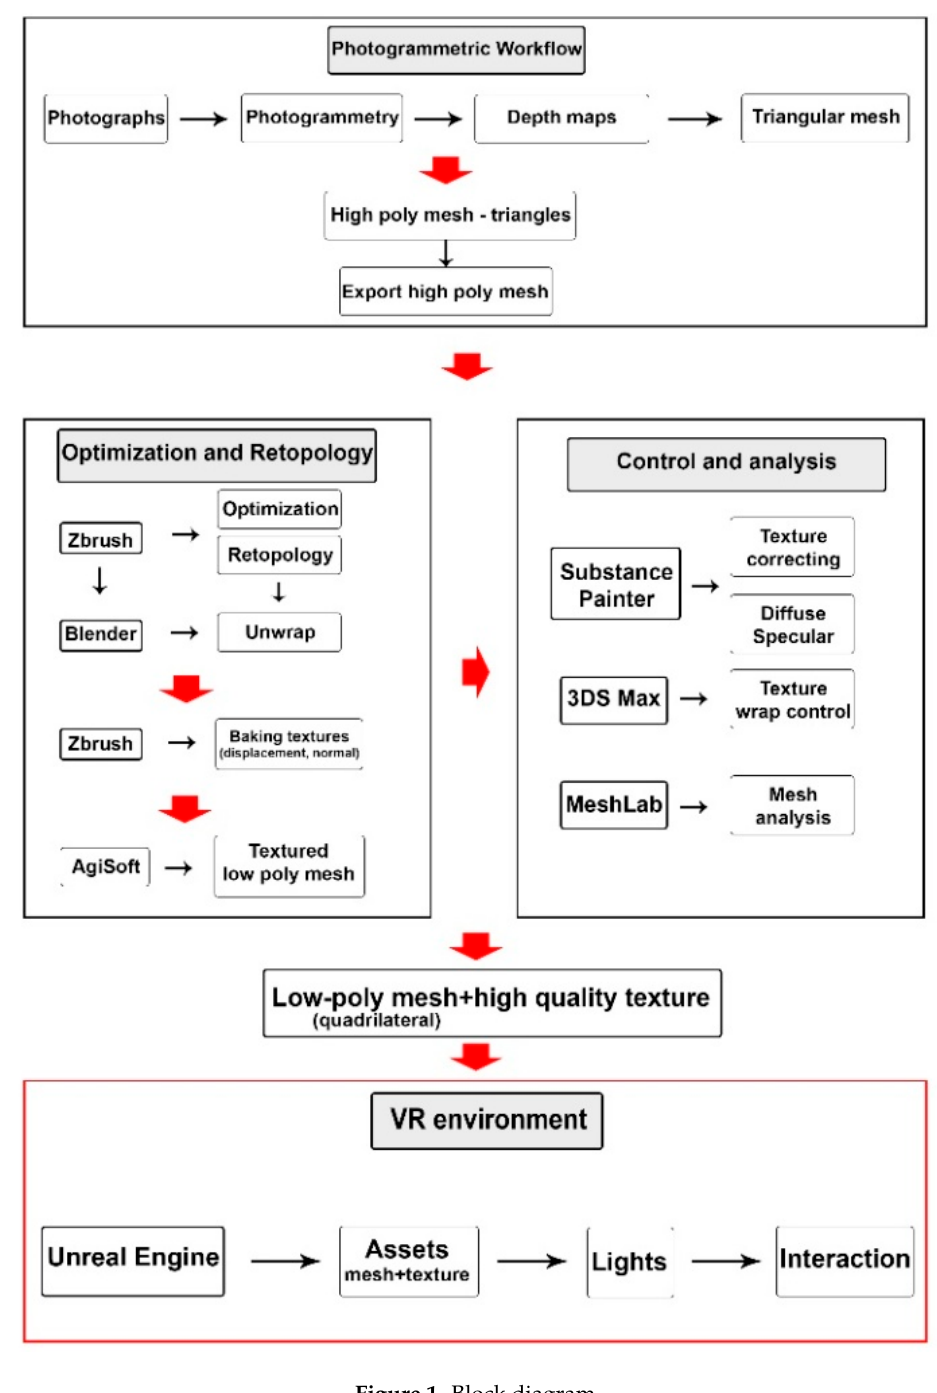
Figure 1. Block diagram.